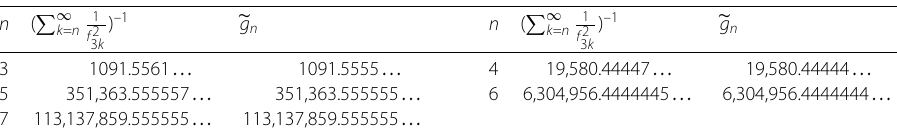
(cid:9) ∞ 1 ) k = n f 2 3 k